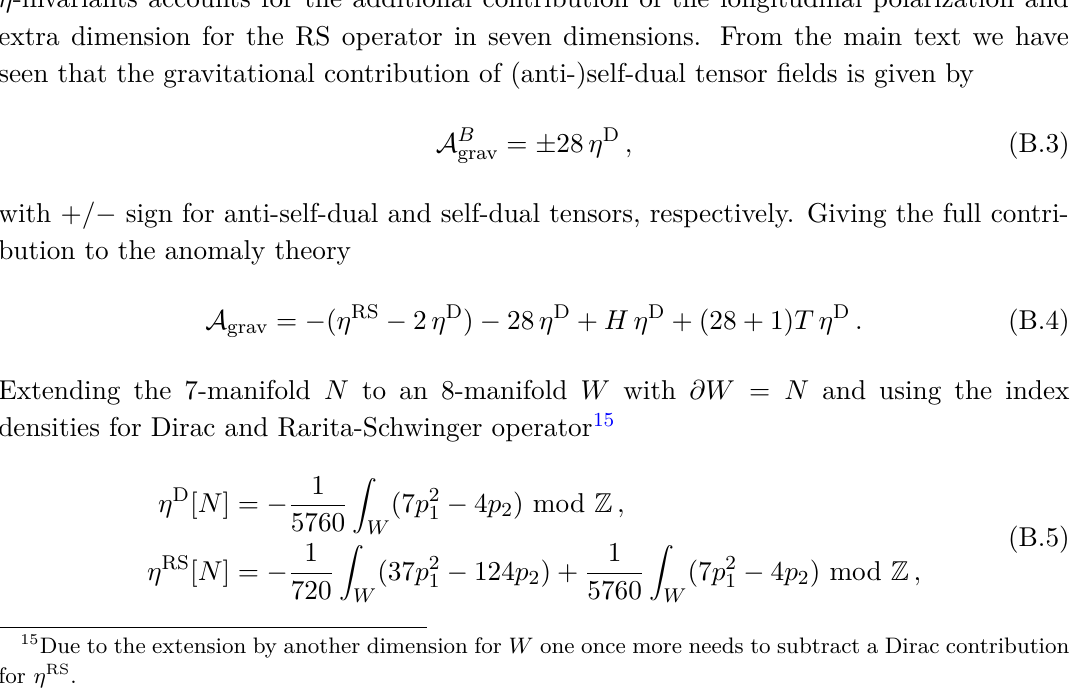
and the data associated to the monad ijk